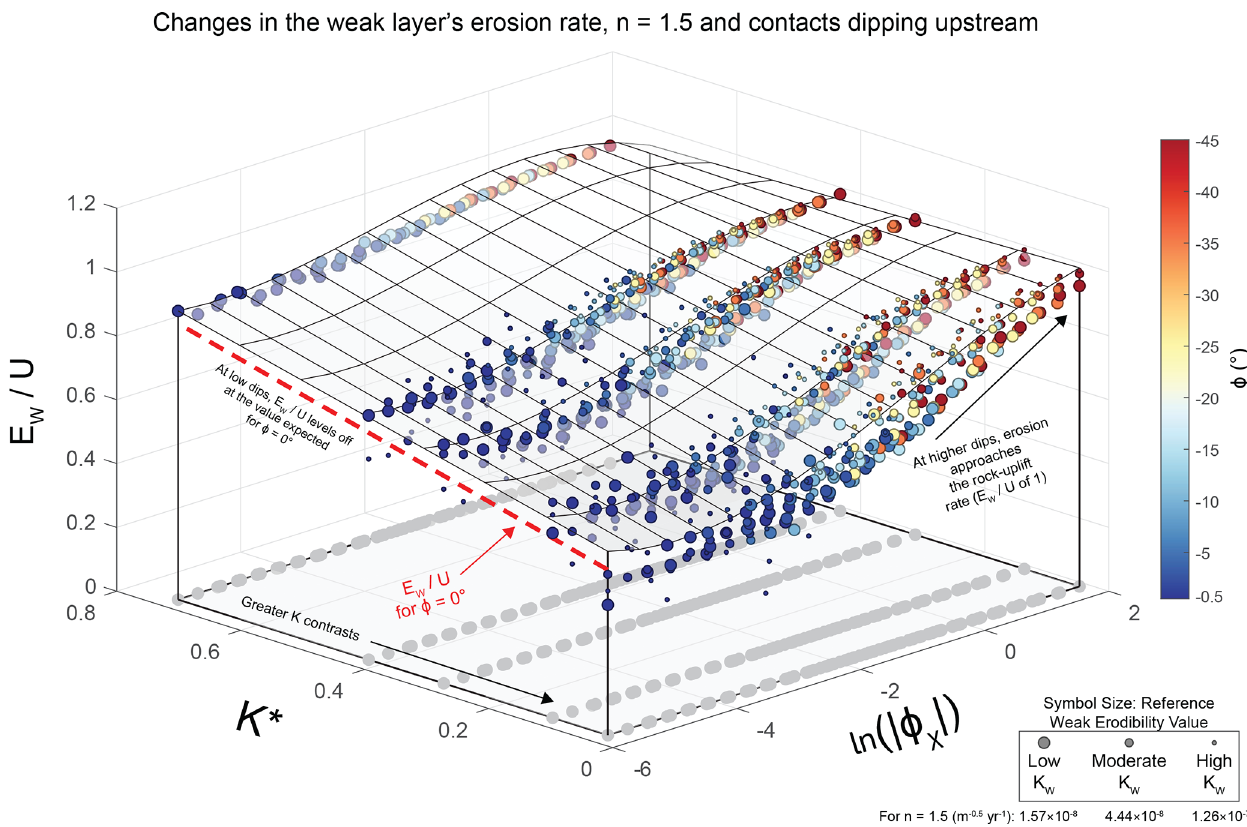
Figure 11. Variations in the average erosion rate in the weak layer ( E W ) normalized by rock-uplift rate ( U ) with both the logarithm of the absolute contact dip in χ space (ln( | φ χ | )) and the enforced K ∗ (Eq. 7c) for simulations with n = 1 . 5 and contacts dipping upstream ( φ < 0 ◦ ). A regression is fit to all data ( R 2 = 0 . 81): E W /U = ( − 2 . 2 × 10 − 3 ln( | φ χ | ) 3 ) + ( − 1 . 7 × 10 − 2 ln( | φ χ | 2 K ∗ ) + ( − 4 . 6 × 10 − 3 ln( | φ χ | ) 2 ) + ( − 1 . 4 × 10 − 1 ln( | φ χ | ) K ∗ ) + (9 . 7 × 10 − 2 ln( | φ χ | )) + (2 . 6 × 10 − 1 K ∗ ) + 8 . 5 × 10 − 1 . The reasons why there are no small symbols for the highest K ∗ are discussed in Sect. S3 (i.e., the damping length scales were too large in those simulations; Perne et al.,